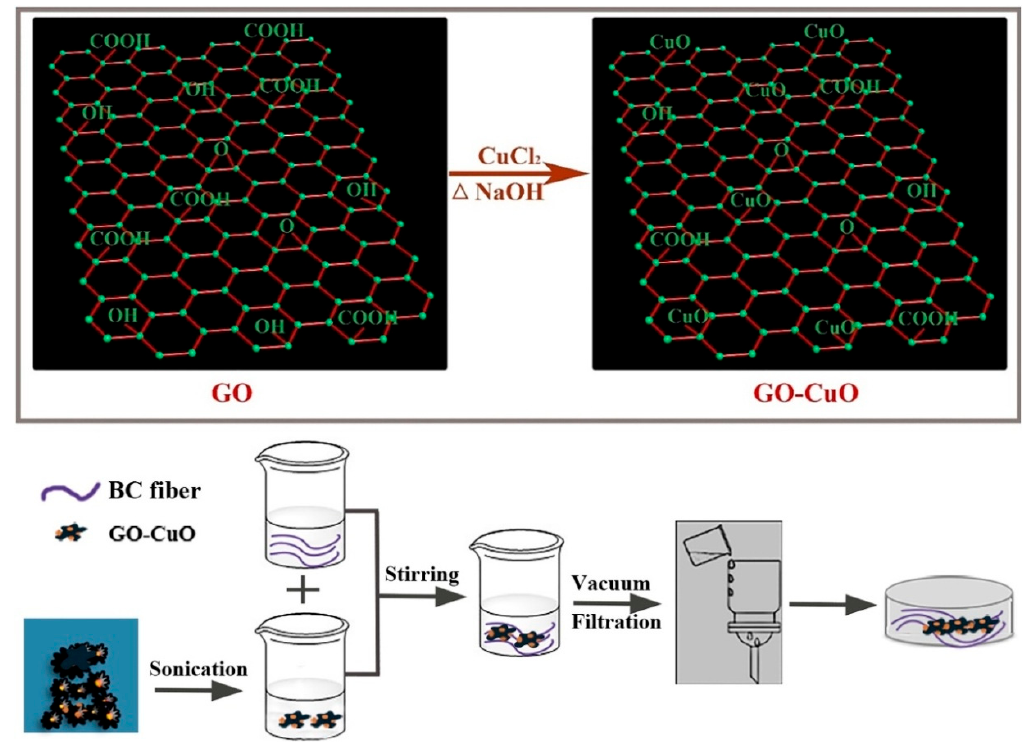
Figure 5. Workflow followed for the development of BC/GO-CuO films [13].